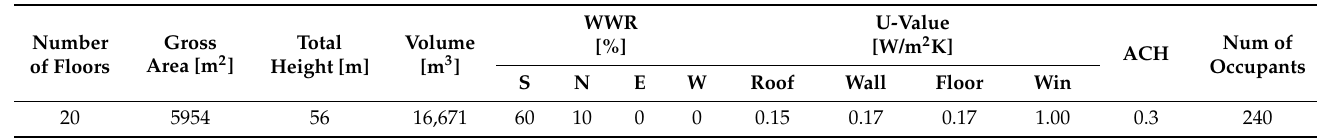
Table 3. Input variable for energy simulation based on Korean building code of multi-stories apart-